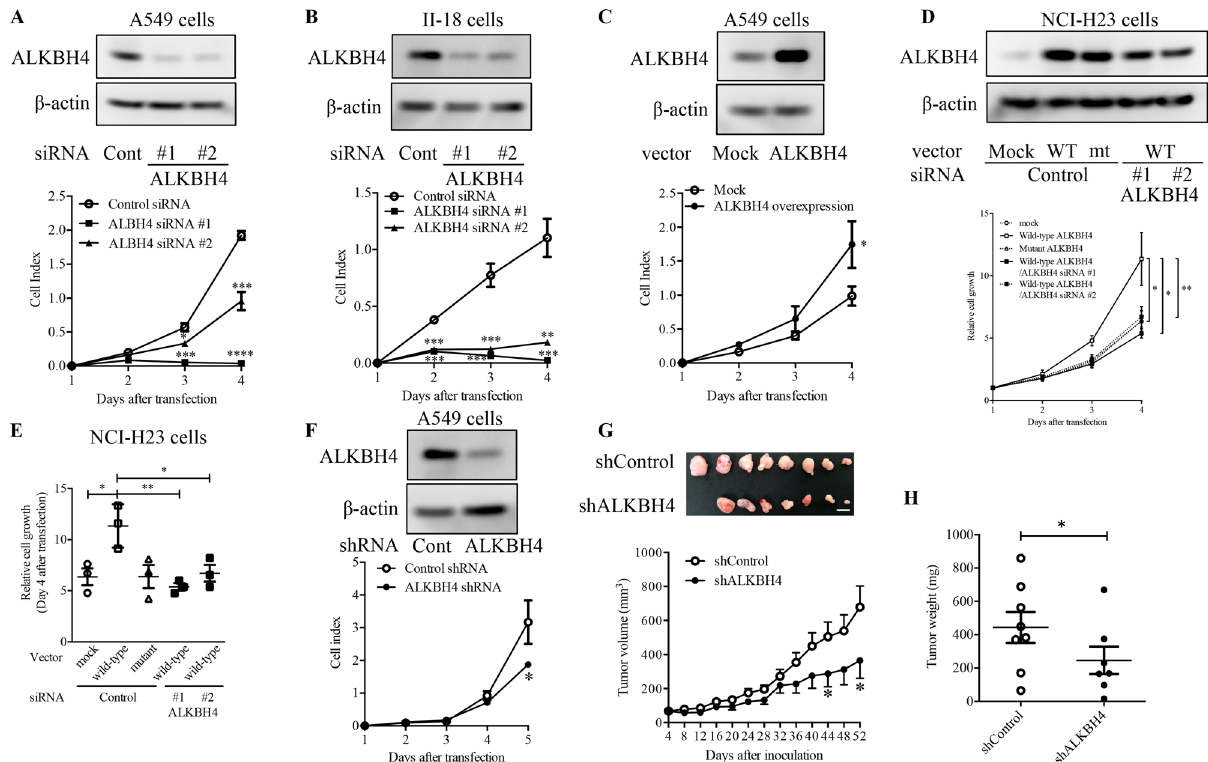
Figure 2. ALKBH4 knockdown suppressed NSCLC cells proliferation. Lysates of A549 ( A ) and II-18 ( B ) cells transfected with two ALKBH4 siRNAs (#1 and #2) or control siRNA, A549 cells transfected with pEB Multi- Neo-ALKBH4 or mock vector ( C ) were subjected to Western blot analysis with anti-ALKBH4 and anti-β- actin antibodies. Uncropped Western blot data are shown in Supplementary Fig. S9. Representative pictures of three independent experiments are shown (upper pictures). The cells which were transfected for 48 h were reseeded on a xCELLigence E-plate and their proliferation was detected using a xCELLigence DP system (lower panels). Degrees of cell proliferation expressed as cell index by the system are the means ± S.D. of three independent experiments ( A – C ). ( D ) Lysates of NCI-H23 cells co-transfected with pEB Multi-Neo-ALKBH4 wild-type (WT), pEB Multi-Neo-ALKBH4 mutant (mt), or mock vector and ALKBH4 siRNAs were subjected to western blot analysis with anti-ALKBH4 and anti-β-actin antibodies. Uncropped Western blot data are shown in Supplementary Fig. S9. Representative pictures of three independent experiments are shown (upper pictures). NCI-H23 cells were transfected for 48 h and reseeded in 96-well plates, and their proliferation was measured using the WST-8 assay (lower panels). The relative cell growth data on day 4 are presented in ( E ). The values are presented as the mean ± S.D. for each group. *p < 0.05; **p < 0.01 vs. wild-type ALKBH4 (one-way ANOVA with Bonferroni post-hoc tests). ( F ) A549 cells stably expressing ALKBH4 shRNA or control shRNA were subjected to Western blot analysis with anti-ALKBH4 and anti-β-actin antibodies. Uncropped Western blot data are shown in Supplementary Fig. S9. Representative pictures of three independent experiments are shown (upper pictures). Cell proliferation was detected using a xCELLigence DP system (lower panels). Degrees of cell proliferation expressed as cell index by the system are the means ± S.D. of three independent experiments (lower panels). ( G ) A549 cells stably expressing ALKBH4 shRNA (shALKBH4) and control shRNA (shControl), which are shown in ( F ), were subcutaneously injected into nude mice. The upper picture shows a xenograft tumour from mice inoculated with shControl- or shALKBH4-expressing A549 cells (shControl: n = 8; shALKBH4: n = 7). White scale bar, 1 cm. Tumour volume was calculated by measuring the tumour size every four days (lower panel). *p < 0.05 vs. control (Student’s t -test). ( H ) Tumour weight in shControl- and shALKBH4 xenografted mice. The values are presented as mean ± S.D. for each group. *p < 0.05 vs. shControl tumour (Student’s t